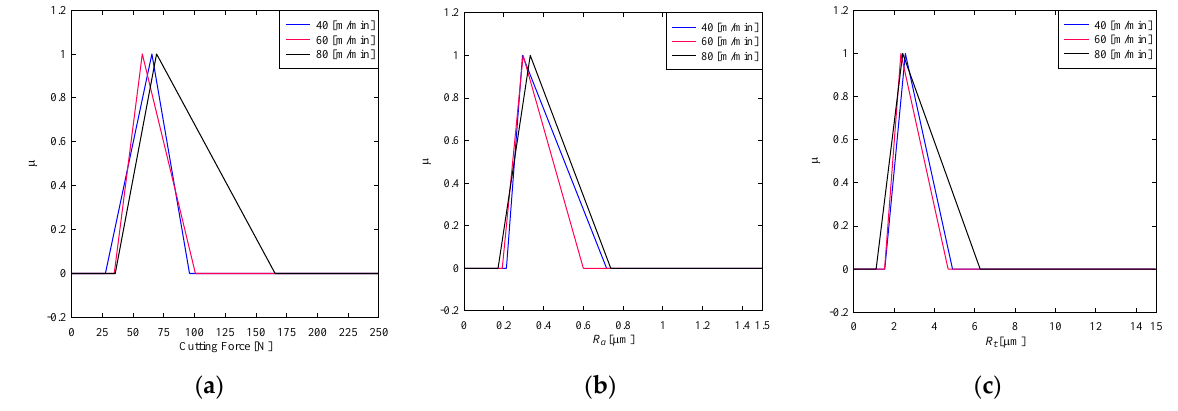
Figure 5. Effect of cutting speed on ( a ) cutting force ( b ) R a ( c ) R t . As seen in Figure 6a, the cutting force decreases with the reduction of the depth of cut. This means that minimizing the cutting force requires minimization of the depth of cut. As seen in Figure 6b, the depth of cut of 0.1 mm ensures a low cutting force. This is not the case for the other two depth of cuts, 0.2 mm and 0.3 mm. As seen in Figure 6c, though the depth of cut of 0.1 mm ensures slightly lower R a , the other two do not lower R a . The same argument holds for R t . For quantitative analysis, the expected values of the cutting force and surface roughness are calculated using the centroid method. The results